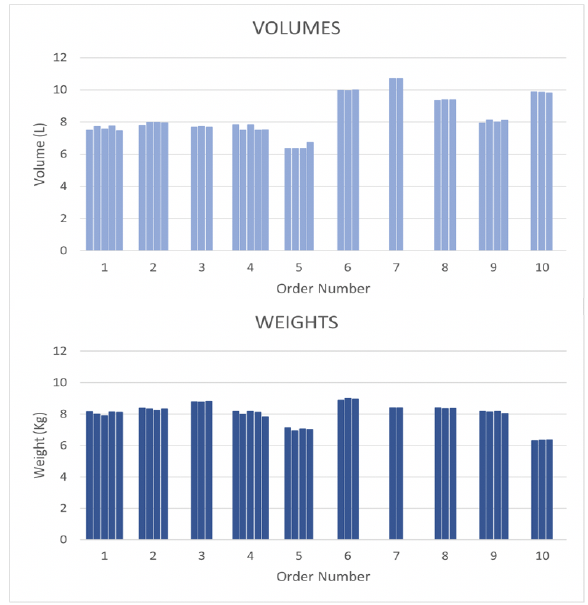
Figure 4. Simulation results for 10 order picking and packing